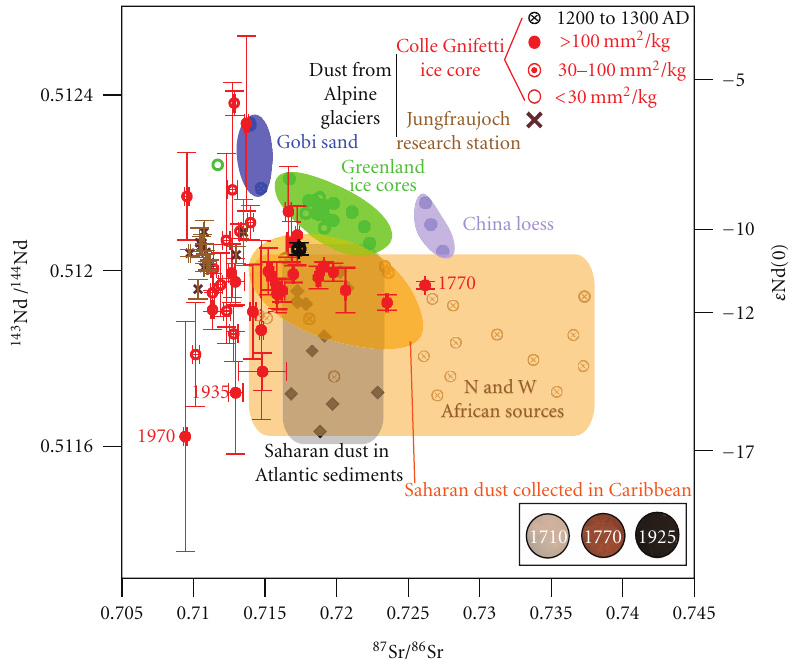
Figure 3: Sr and Nd isotopic data from Jungfraujoch samples (JFJ, crosses) and from Colle Gnifetti ice core (CG, circles) as a function of the total aerosol surface, compared to dust values from Gobi desert, China loess, Greenland ice cores (empty circles: GISP2, filled circles: GRIP), < 30 μ m fraction of Atlantic sediments (filled diamond), North African and central-Sahara/Sahel derived aerosols recovered over the island of La Martinique (Caribbean, empty squares), and north African sand deposits (closed circles). The digital images of three filters, respectively, depleted in insoluble minerals (ca. 1710), enriched in Saharan dust (ca.1770) and enriched in fossil fuel combustion products (ca. 1925). Data sources: Biscaye et al. [24]; Grousset et al. [25]; Svensson et al. [8]; Delmonte et al. [10]; Grousset and Biscaye